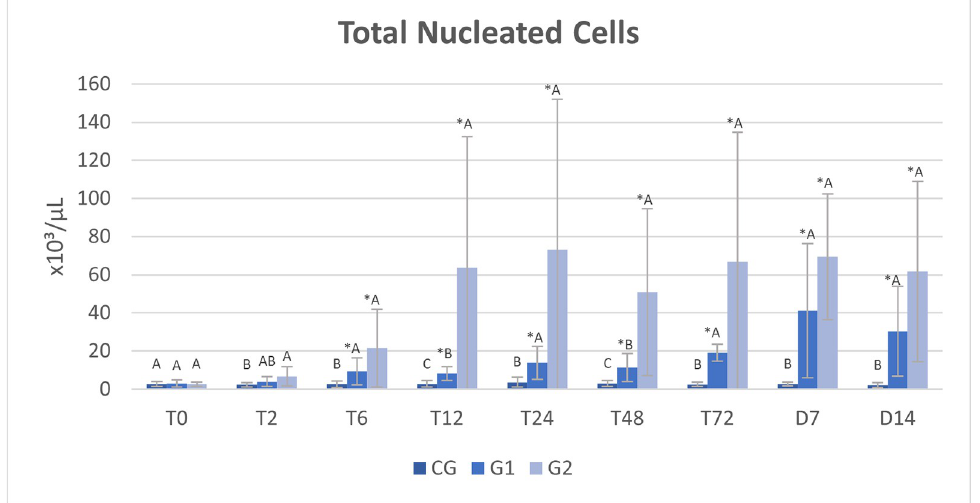
Fig 3. Mean and standard deviation (SD) of total nucleated cells count in the peritoneal fluid of healthy horses (CG) and horses submitted to cecal trocarization with a cecal needle (G1) or a cattle trocar (G2).